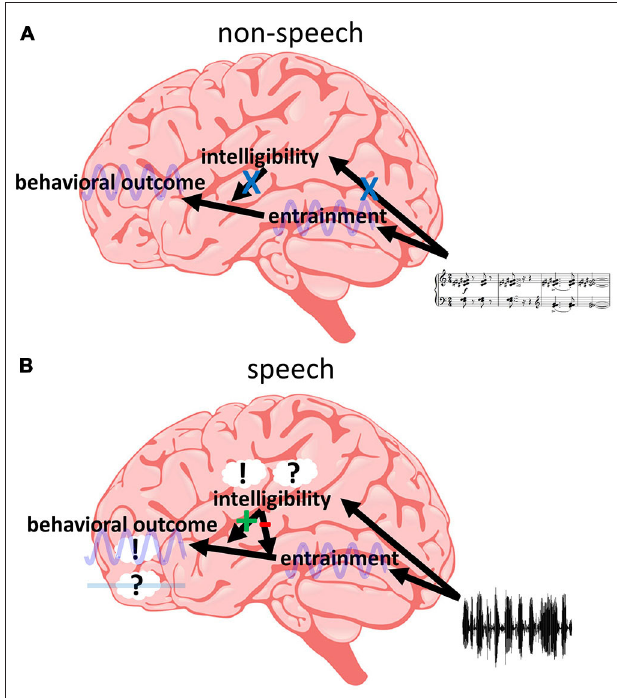
FIGURE 5 | Intelligibility at the interface between phase entrainment and behavior. (A) Non-speech stimuli do not activate speech-specific (“intelligibility”) regions. Thus, entrainment in temporal regions can directly influence behavior—determined in frontal regions—in a periodic fashion, without an additional modulation by speech-specific regions. (B) Acoustic high-level features of speech activate speech-specific regions. This activation results in a modulation of the connectivity between temporal and frontal regions. If linguistic high-level features are present in the input (i.e., if the speech is intelligible), temporal and frontal regions are synchronized and entrainment in temporal regions can affect activity in frontal regions (and modulate behavior periodically, such as in A ). If these features are not present (i.e., if the speech is unintelligible), temporal and frontal regions are desynchronized and entrainment in temporal regions cannot affect frontal regions and behavior. Thus, (only) if the input is recognized as speech, intelligibility can act as a “switch”, determining the influence of entrained oscillations on behavioral